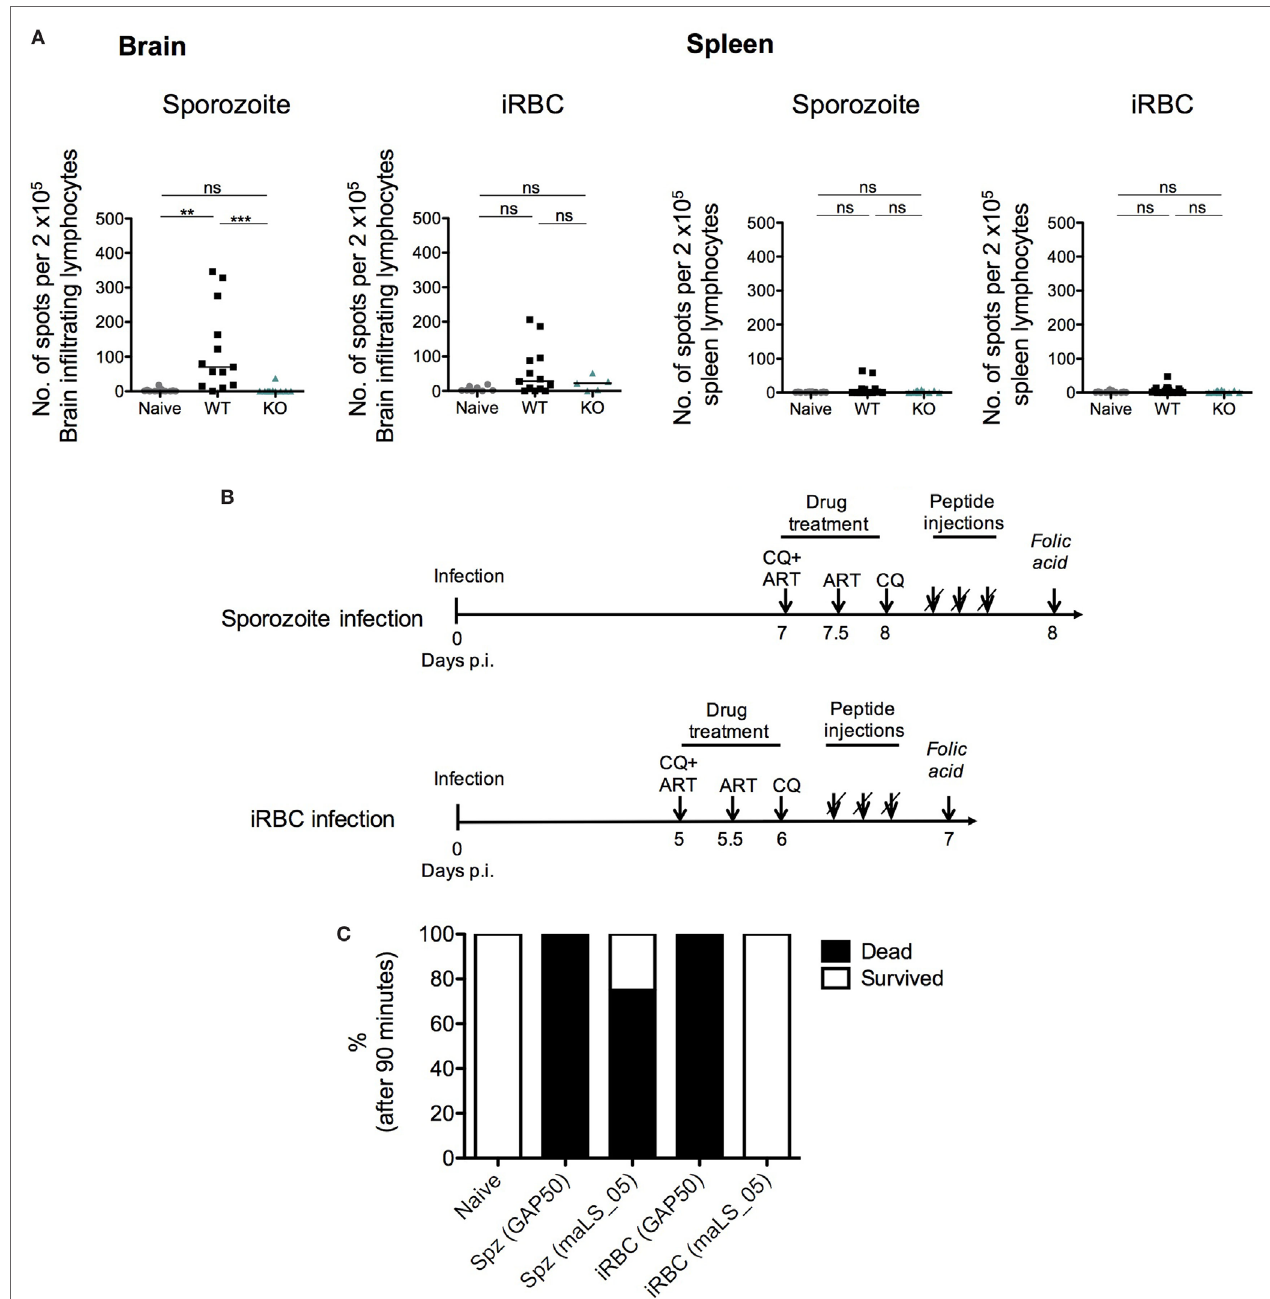
FigUre 9 | Pb maLS_05-specific T cells contribute to the development of experimental cerebral malaria (ECM), after sporozoite- but not infected red blood cell (iRBC)-induced infection. (a) Pb maLS_05-specific CD8 + T cells accumulate in the brain predominantly after sporozoite infection. The experimental setup used was identical to the one described for the cross-presentation assay. Lymphocytes derived from brains and spleens of infected and naïve mice were used to perform an IFN- γ ELISpot assay. Brain-infiltrating lymphocytes and splenocytes from infected mice were cultured together with antigen-presenting cells (APCs) (naïve splenocytes) that were previously pulsed with a pool of Pb maLS_05 peptides or Pb1 peptide of GAP50. APCs pulsed without peptides were cultured together with lymphocytes, as control. Statistical significance was determined by One-way ANOVA with Bonferonni’s correction for the spleens and Kruskal–Wallis with Dunn’s multiple comparison for the brains (*** p < 0.0001, ** p < 0.001, ns; not significant). The results shown with median are pooled from two independent experiments ( n = 10–12 mice per group; n = 5 mice for KO-iRBC). (B) Experimental setup to test in vivo cytotoxicity of Pb maLS_05-specific CD8 + T cells. 5 Pb ANKA iRBC- infected and 4 Pb ANKA sporozoite-infected mice were injected with Pb maLS_05 peptides; 2 iRBC-infected and 3 sporozoite-infected mice were injected with the Pb1 (GAP50) peptide and 5 mice were used as naïve controls. (c) Pb maLS_05-specific CD8 + T cells are responsible for the development of ECM in sporozoite- infected mice. Groups of mice were infected according to the described schedule (B) and treated with antimalarial drugs (CQ + ART) prior to injections with peptides. One day after the peptide injection, all mice were challenged with two injections of folic acid, 1 h apart. The bar graph represents percentage survival in each group, after 90 min. The data shown are representative of a single experiment.